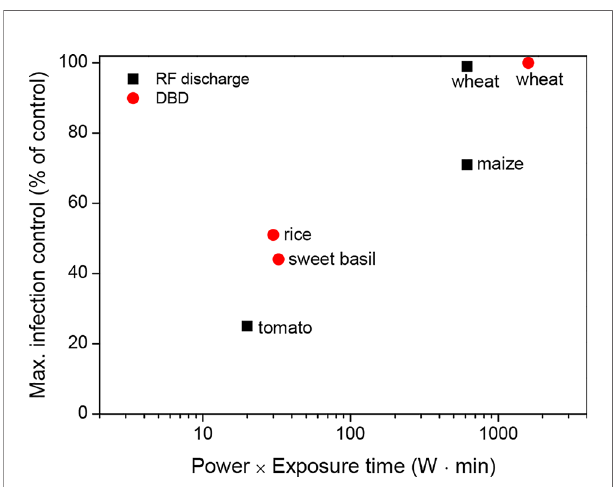
FIGURE 3 | Maximum infection control (% of control) as a function of the power (W) and exposure time (min) of the plasma treatments for a few crops, which were described in the literature presented in Table 2